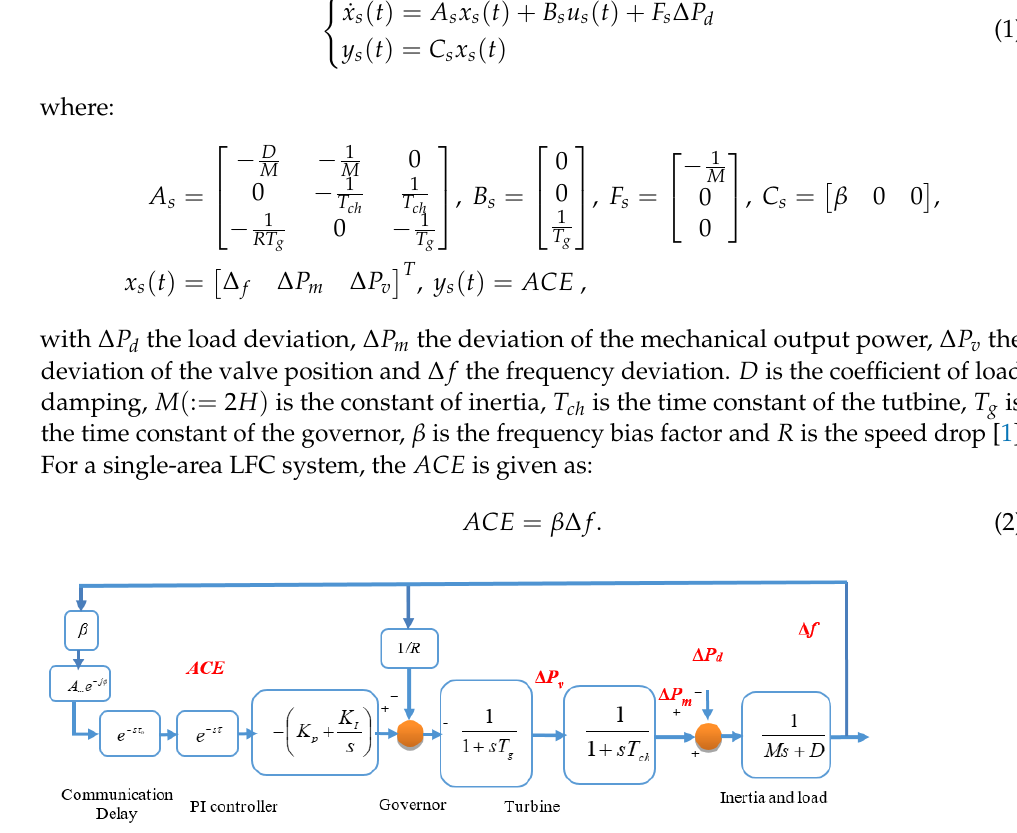
Figure 1. The dynamic model of a single-area LFC with phase and gain